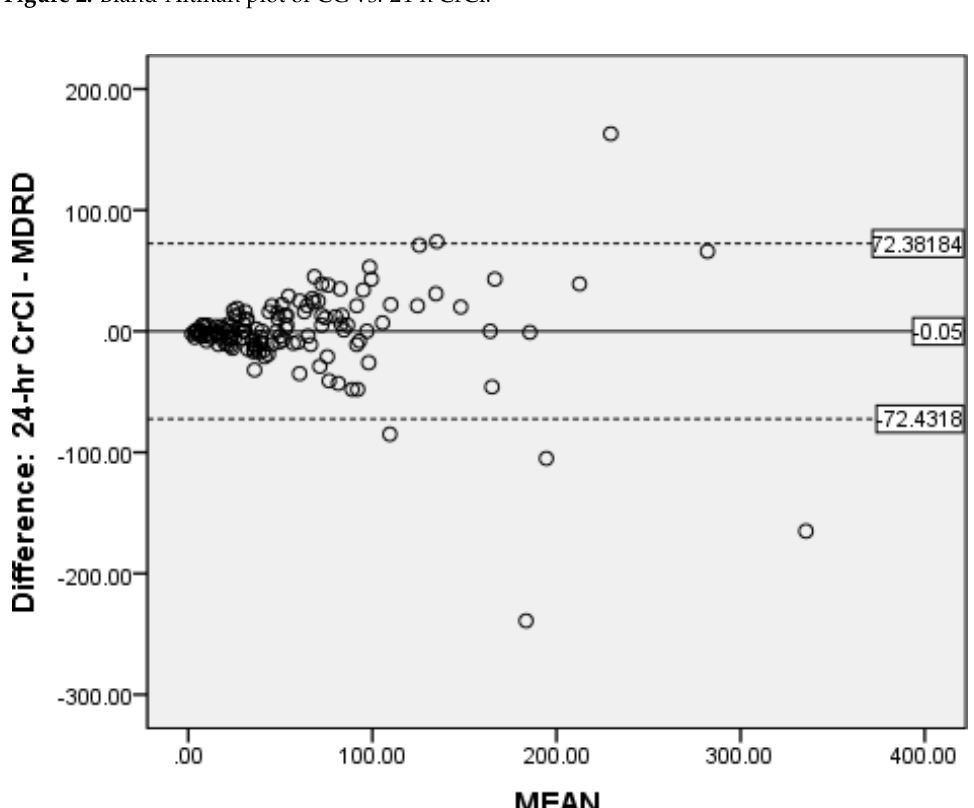
Figure 3. Bland-Altman plot of MDRD vs. CrCl.